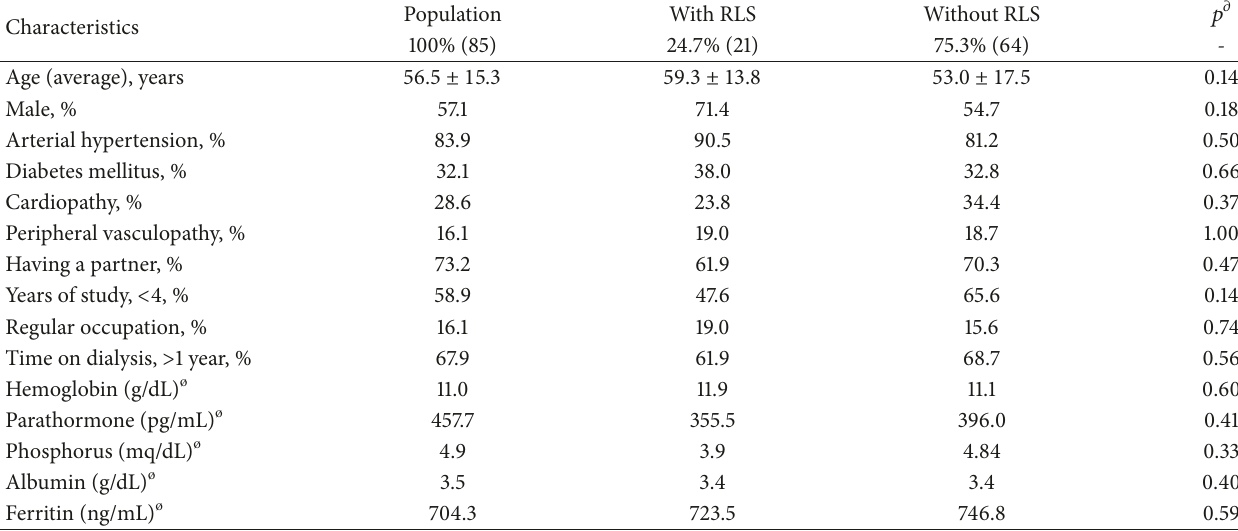
Table 2: Distribution of peritoneal dialysis patients according to clinical-demographic characteristics, segregated according to the diagnosis of restless legs syndrome (RLS) ¢ ( 𝑁 = 85